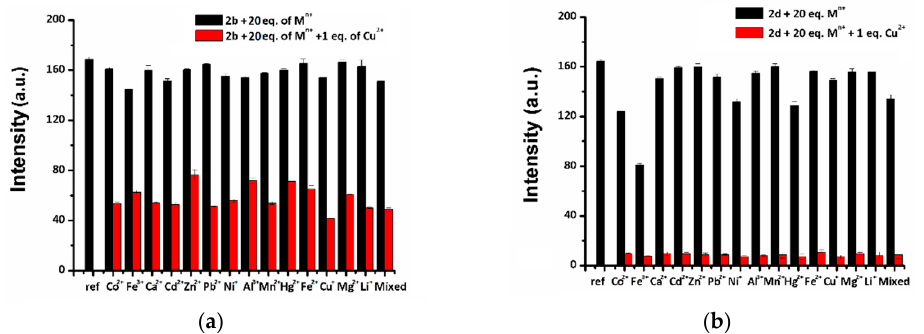
Figure 5. Fluorescence emission intensities of solutions containing 20 eq. of various cations and ( a ) 2b and ( b ) 2d (both 30 μ M) in the presence (red bars) and absence (black bars) of 1 eq. of Cu 2+ in DMSO/HEPES buffer.